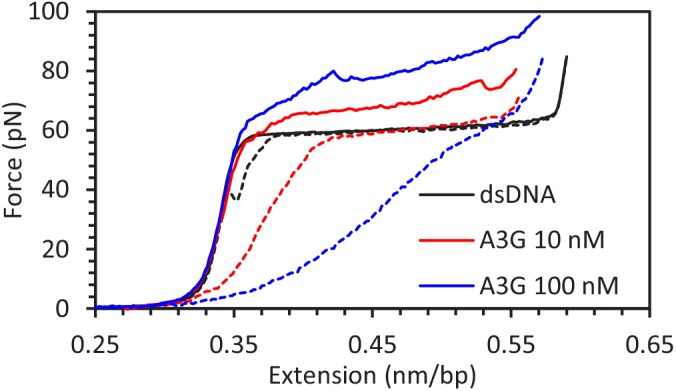
A3G binding to dsDNA.FECs of dsDNA in protein free buffer (black line) or in the presence of A3G (blue and red lines) overlap below the melting transition, indicating that A3G binding does not alter dsDNA polymer properties. The force required to overstretch dsDNA increases and binding to exposed ssDNA prevents reannealing of bases when the force is lowered (dashed lines).